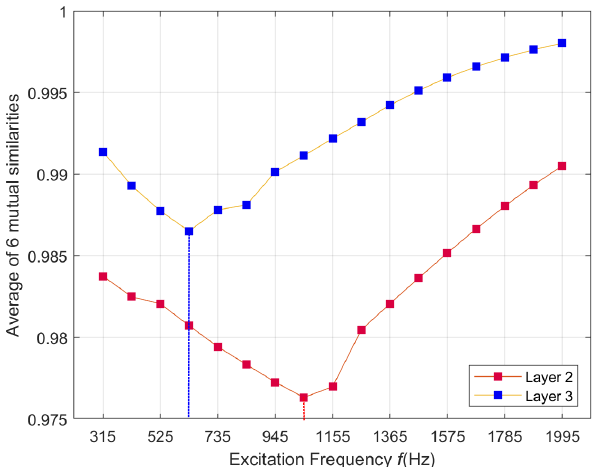
Figure 23. Frequency dependence of the average of mutual similarities calculated using the pro- posed method.